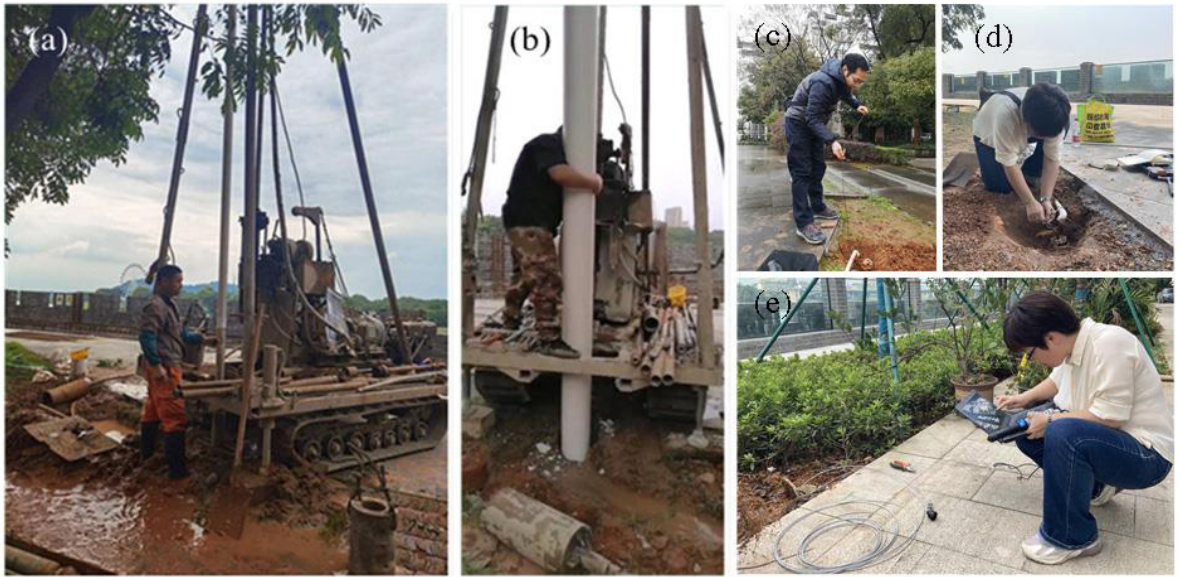
Figure 12. Installation of water level logger and extraction of monitoring data: ( a ) drilling; ( b ) hole wall reinforcement; ( c ) put into the water level logger; ( d ) fixed position; ( e ) extract Data.